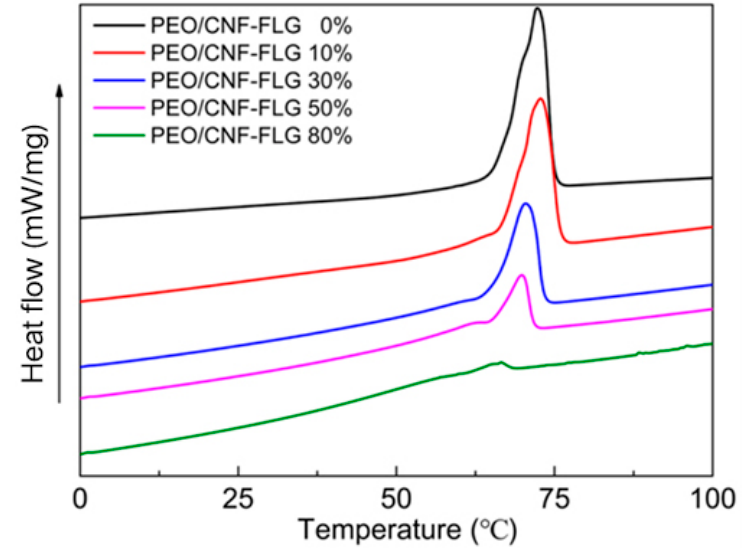
Figure 4. DSC curves of various PEO/CNFs-FLG composites. Table 2. T m , ∆ H f and degree of crystallinity for various PEO/CNF-FLG composites.